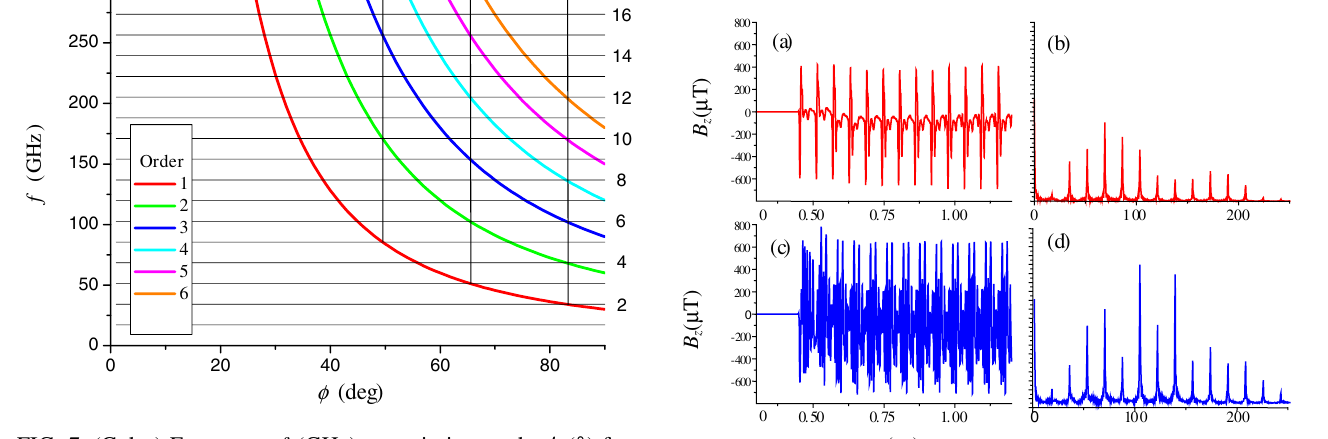
FIG. 9. (Color) Magnetic field at 48 (cid:6) : (a) B with a flat ground plane. The same, but with the grating, are shown in (c) and (d)